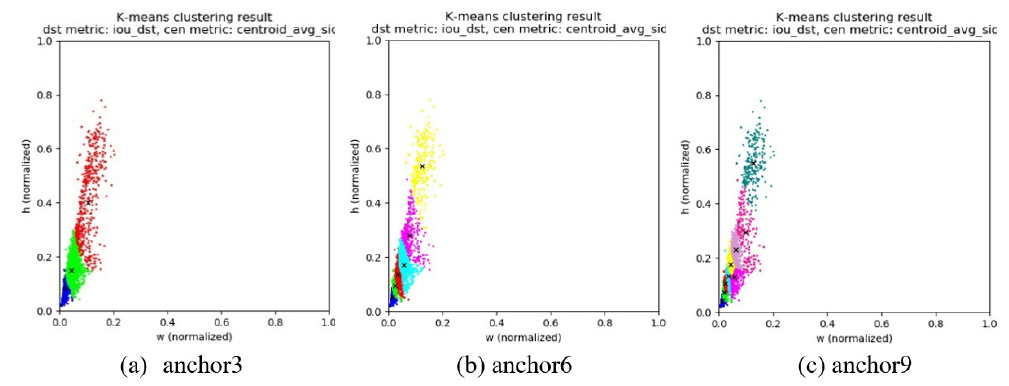
Figure 4. Clustering results on different number of anchor boxes.